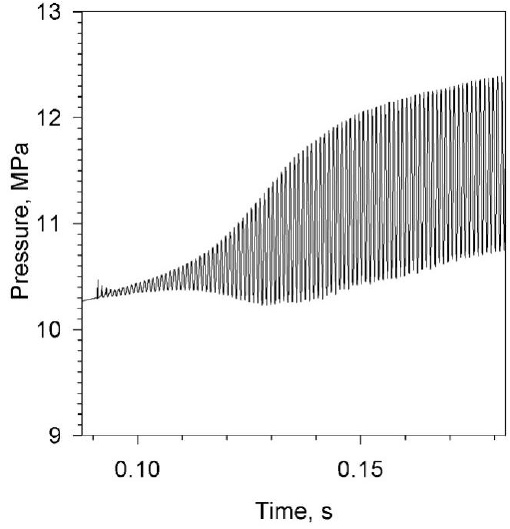
Figure 4. Predicted head-end pressure-time profile, reference motor ( K Δ H = 150,000 J/kg; Δ p s